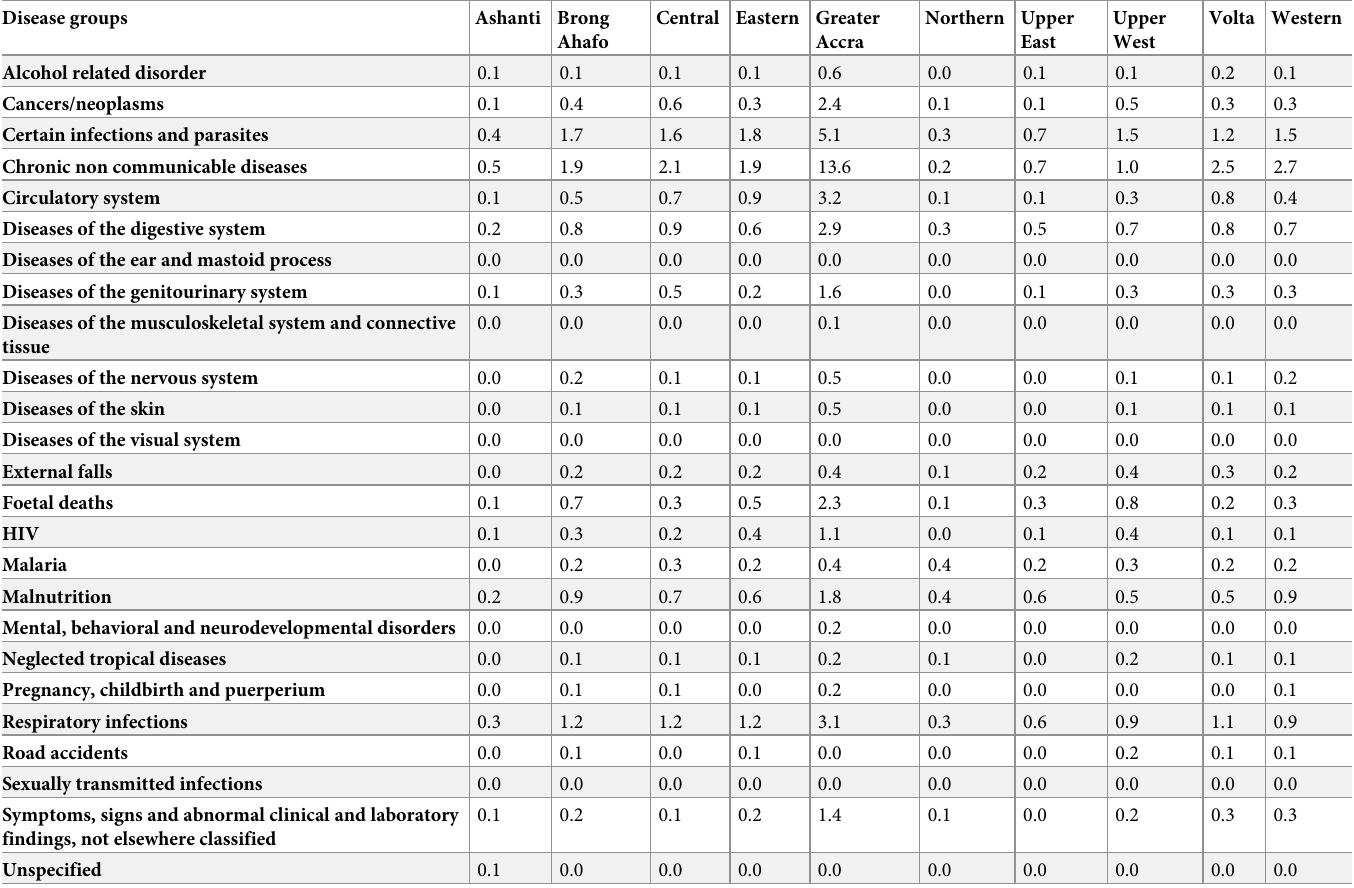
Table 5. Mortality rate by disease groups in 2017 at health facilities in Ghana, by